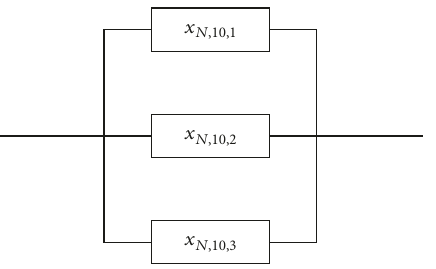
Figure 5: Block diagram of the network unit 𝑥 1,10 .